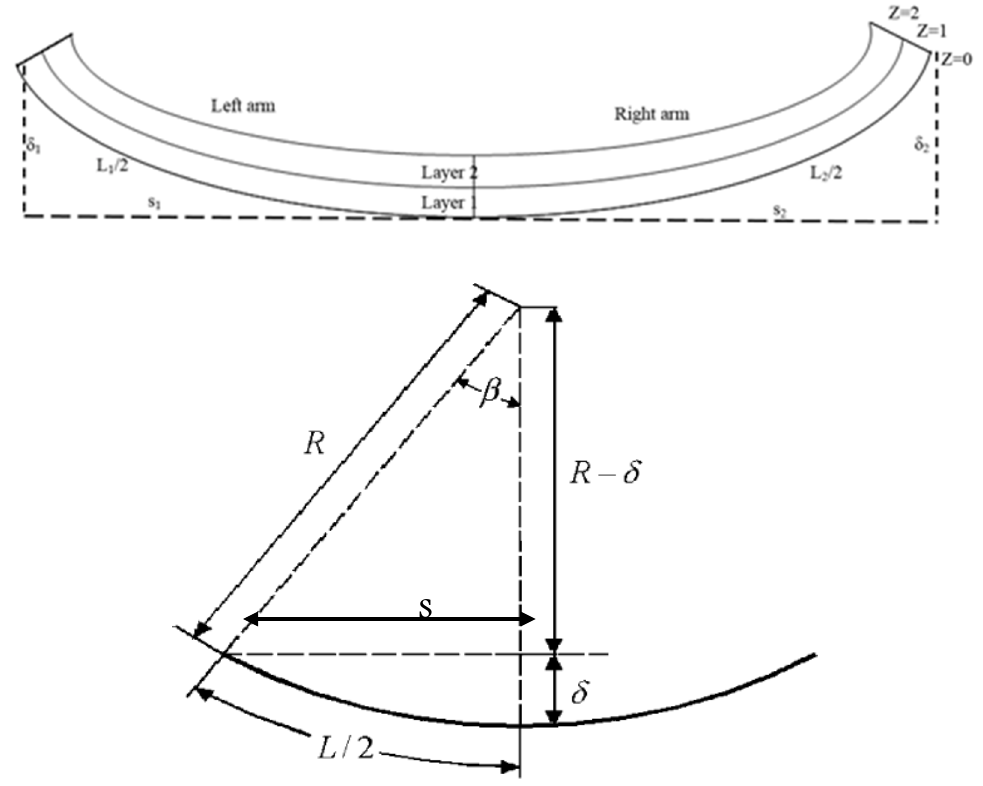
Figure A1. Schematic of printed material having undergone shrinkage.